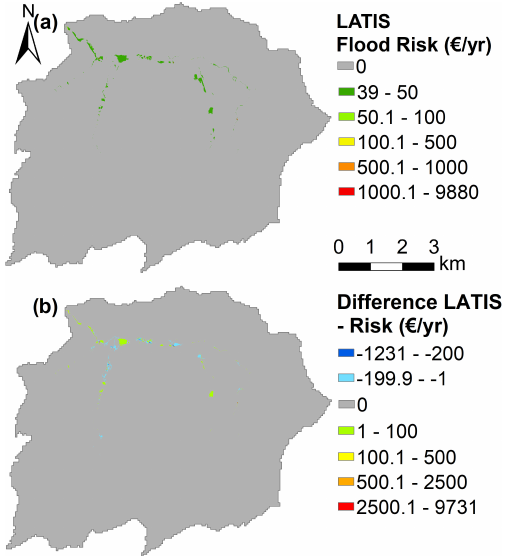
Figure 12. (a) Flood risk (EUR per year per pixel of 25m 2 ) in the Maarkebeek catchment as calculated by the LATIS tool based on the flood damages determined for flood events with a return period of 10, 100 and 1000 years (adapted from VMM, 2015) (source: VMM et al., 2020). (b) Difference in flood risk (EUR per year per pixel of 25m 2 ) between the flood risk determined by the LATIS tool and as calculated based on the four observed flood events in the Maarke- beek